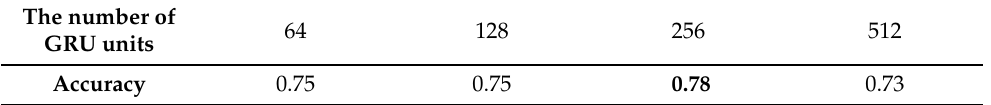
Table 4. The classification accuracy of the psychological stress of the GRU network of the proposed method under different numbers of neural units. The number in bold represents the best result.